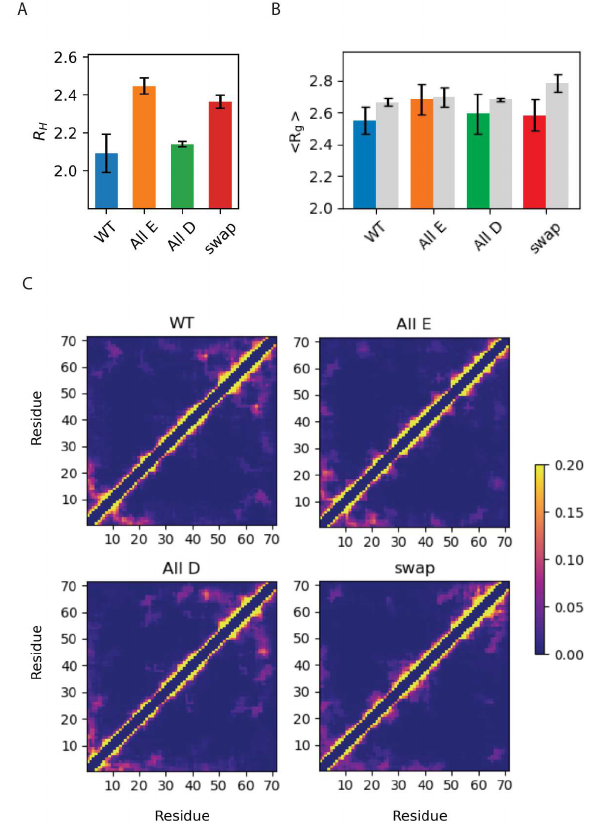
Figure 5. Global chain properties of Dss1 WT, All-E, All-D and Swap. ( A ) The hydrodynamic radius (nm) determined via diffusion NMR; ( B ) average radius of gyration (nm) determined experimentally via SAXS (color) or via MD simulations (gray); ( C ) contact maps showing the frequency of contacts between each of the 71 residues in the four Dss1 variants in the MD simulations, where yellow corresponds to an interaction found > 20%.